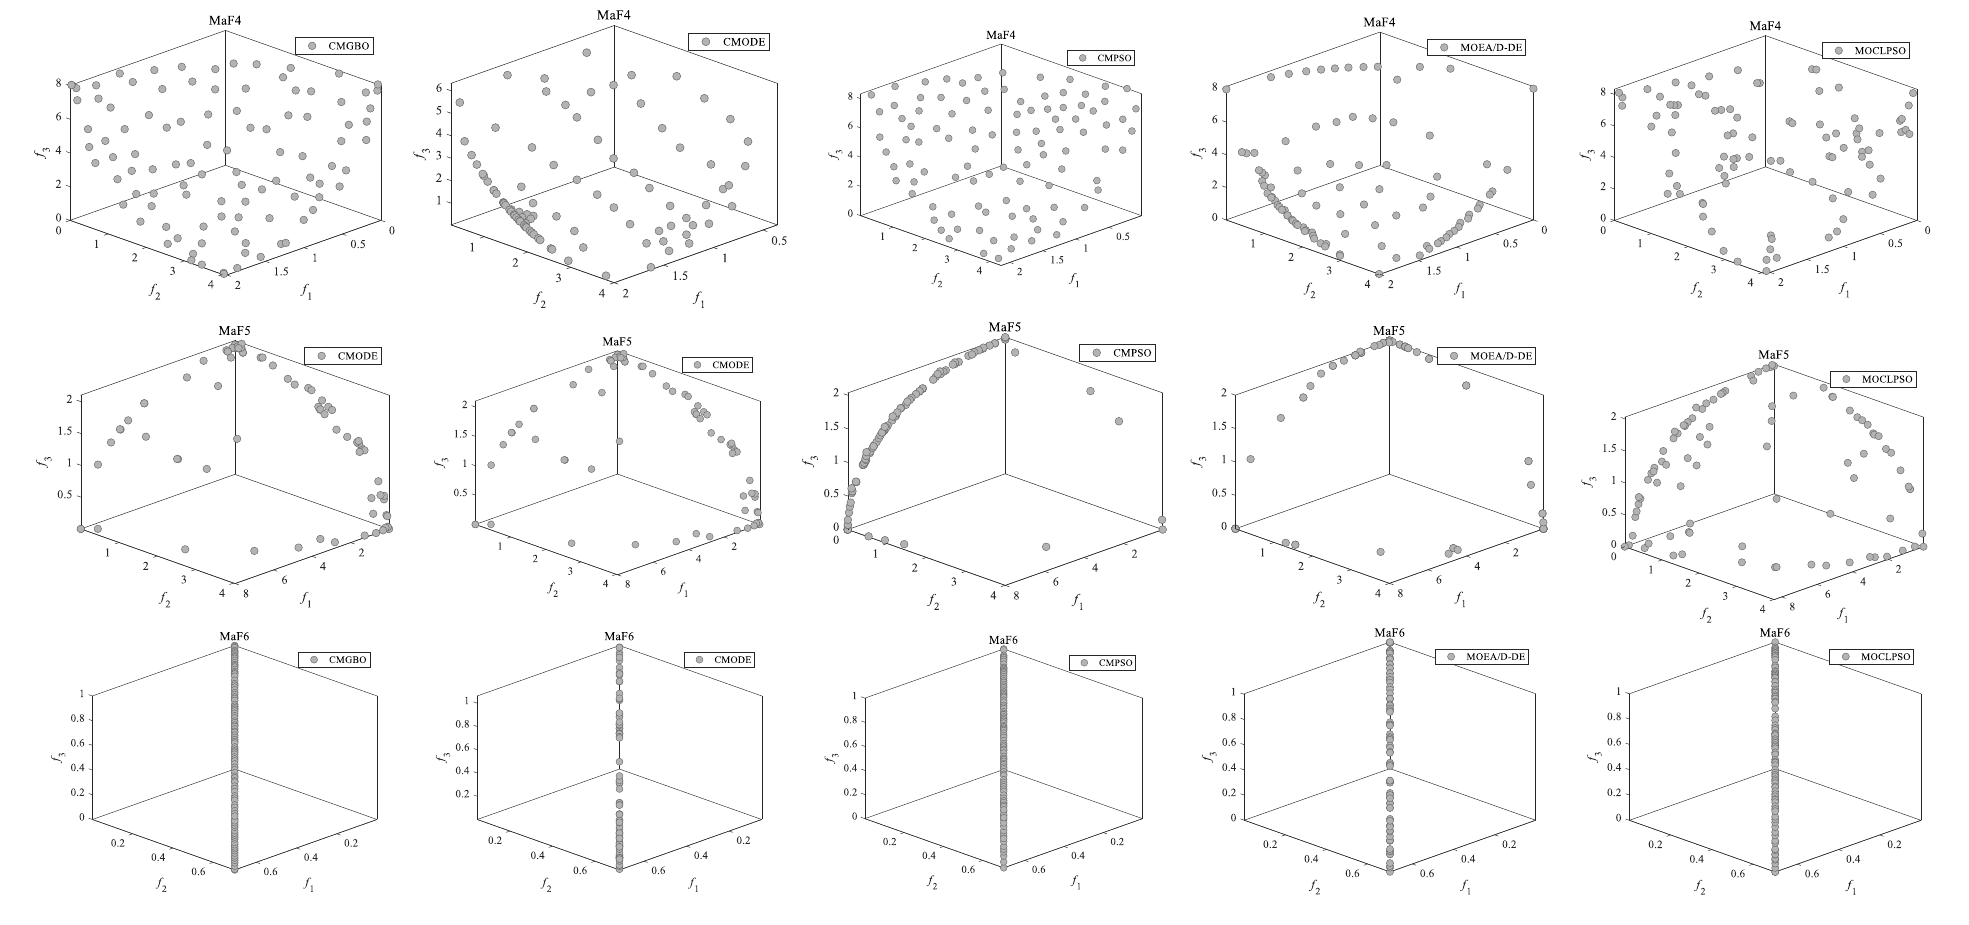
Figure 8. Best Pareto fronts of MaFs obtained by each algorithm.